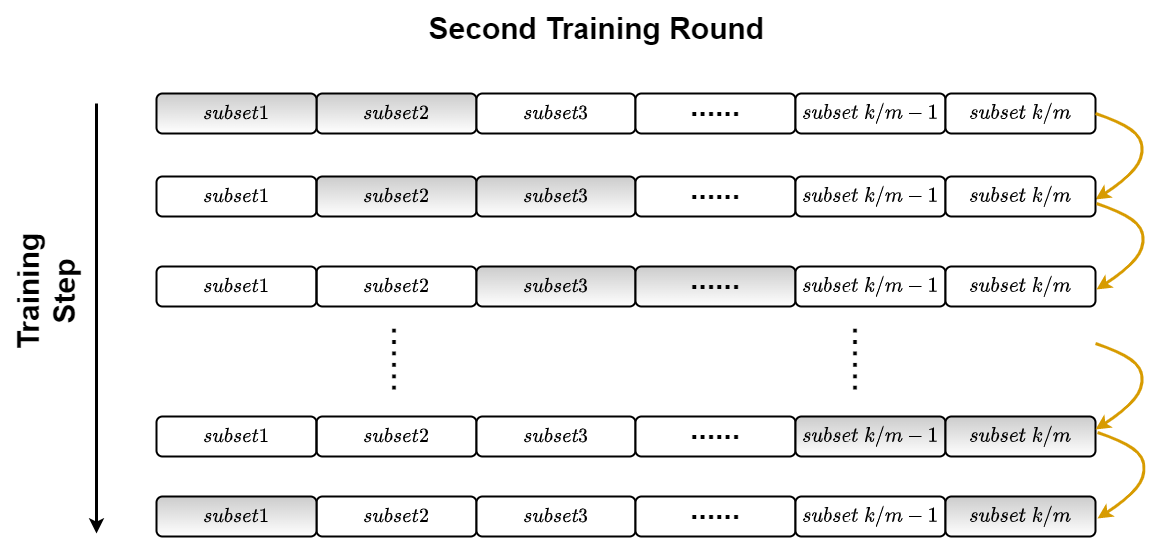
Figure 5. An overview of the second-round of pre-learning The challenge bits of two subsets in color are unfixed, and the rest of the bits are fixed.